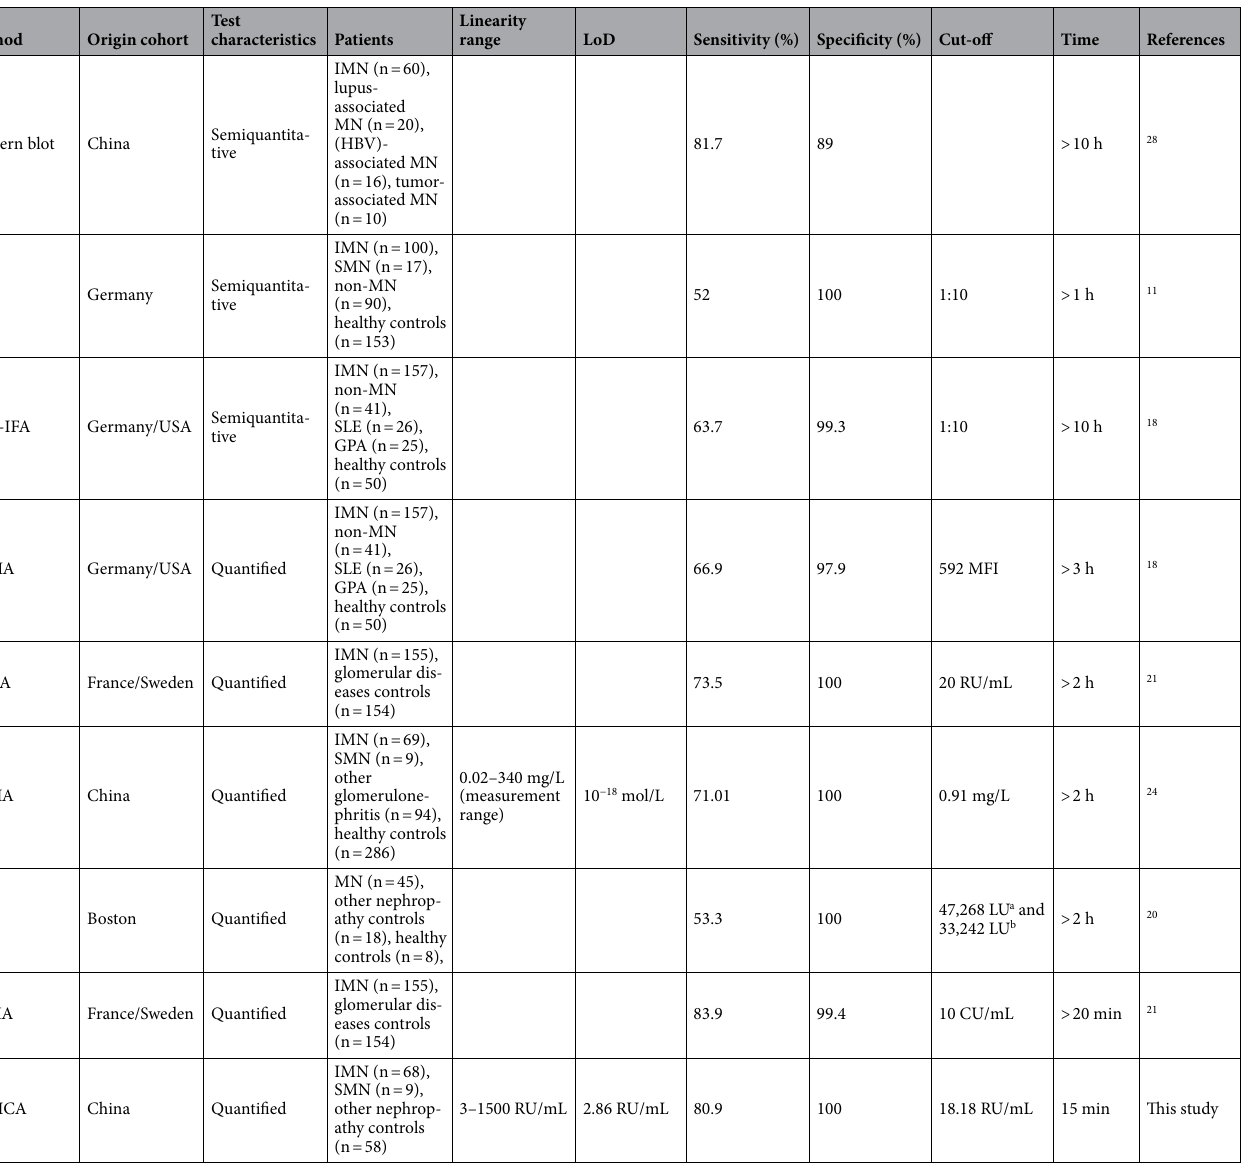
Table 5. Comparison of the analytical performance of different methods for detecting the anti-PLA2R antibody. IIFA indirect immunofluorescence assay, SLE systemic lupus erythematosus, GPA granulomatosis with polyangiitis, CU/mL chemiluminescent units per milliliter. a Gaussian luciferase reporters. b Nano- luciferase